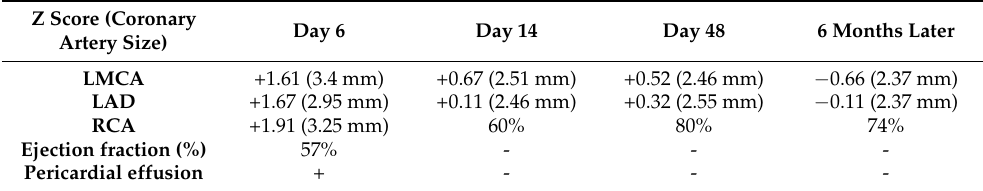
Table 1. The serial echocardiographic features of the patient. (LMCA: left main coronary artery, LAD: left anterior descending artery, RCA: right coronary